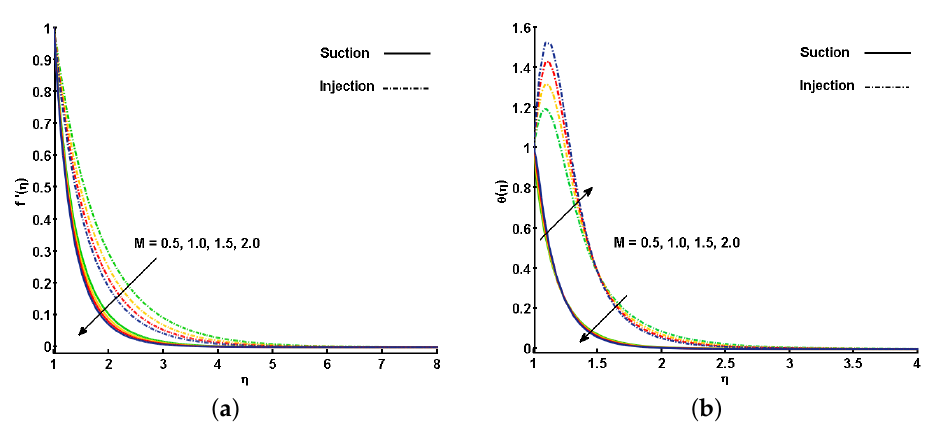
Figure 4. Effect of magnetic parameter ( M ) on ( a ) velocity profile ( f (cid:48) ( η )) and ( b ) temperature profile ( θ ( η )